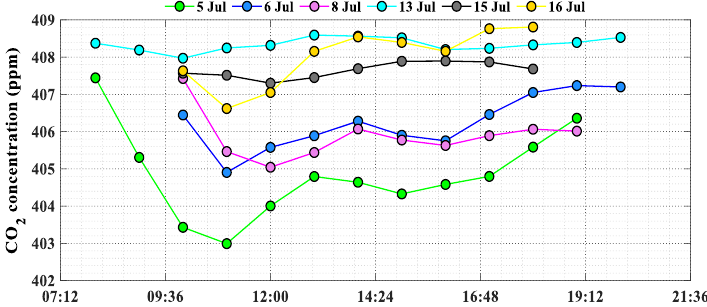
Figure 6. Diurnal variation of CO 2 concentration measured by UGGA at CRCS ground station.